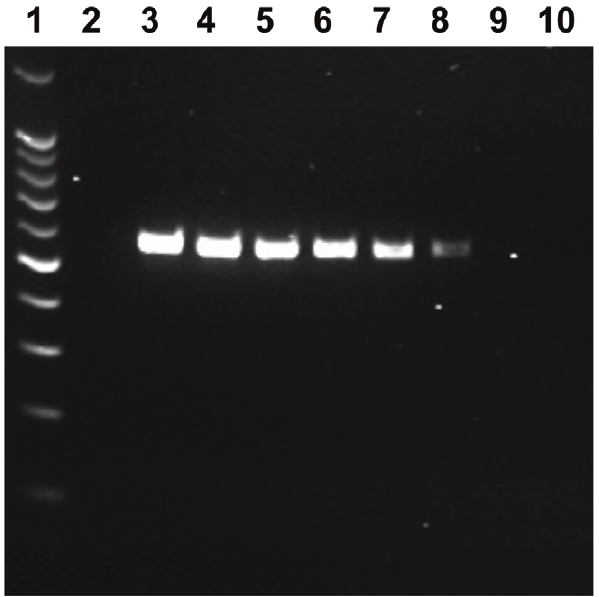
Figure 2. Limit of detection for the newly developed S. wadsworthensis -specific nested PCR assay. The PCR assay was able to detect 0.5 pg of S. wadsworthensis DNA. Lane 1: 100 bp marker, Lane 2: negative control (no DNA), Lane 3: S. wadsworthensis DNA 50 ng/ m l, Lane 4: S. wadsworthensis DNA 5 ng/ m l, Lane 5: S. wadsworthensis DNA 0.5 ng/ m l, Lane 6: S. wadsworthensis DNA 50 pg/ m l, Lane 7: S. wadsworthensis DNA 5 pg/ m l, Lane 8: S. wadsworthensis DNA 0.5 pg/ m l, Lane 9: S. wadsworthensis DNA 0.05 pg/ m l, Lane 10: S. wadsworthensis DNA 0.005 pg/ m l.